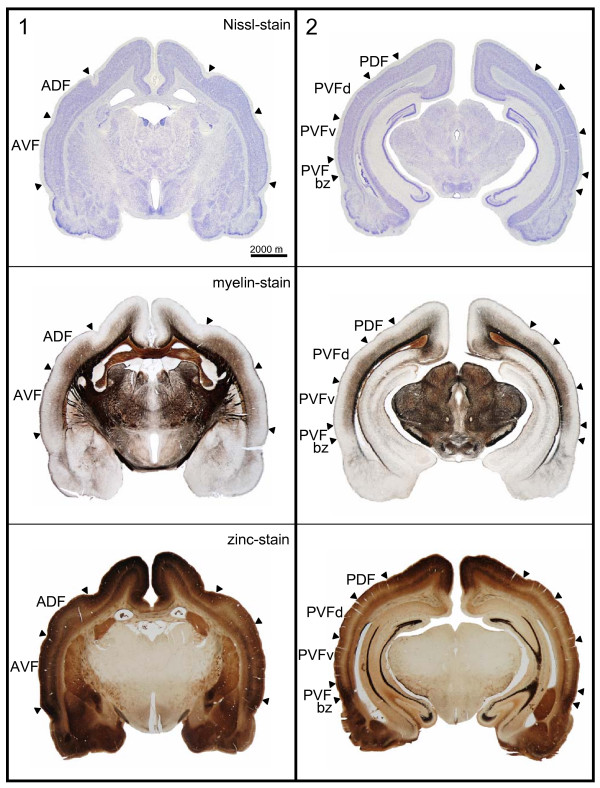
Frontal sections at two rostro-caudal levels. The frontal sections are shown for position indicated by the vertical lines in Fig. 1A. Top row: sections (40 μm thick) stained for cells (Nissl); middle row: neighboring sections stained for myelin; bottom row: sections stained for zinc at comparable rostro-caudal level from another series. Scalebar: 2000 μm. Abbreviations as in Fig. 1C.